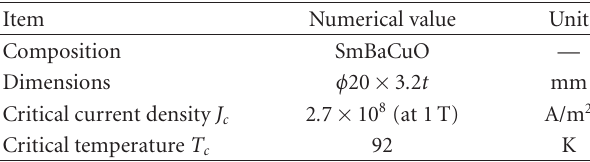
Table 4: Specifications of the